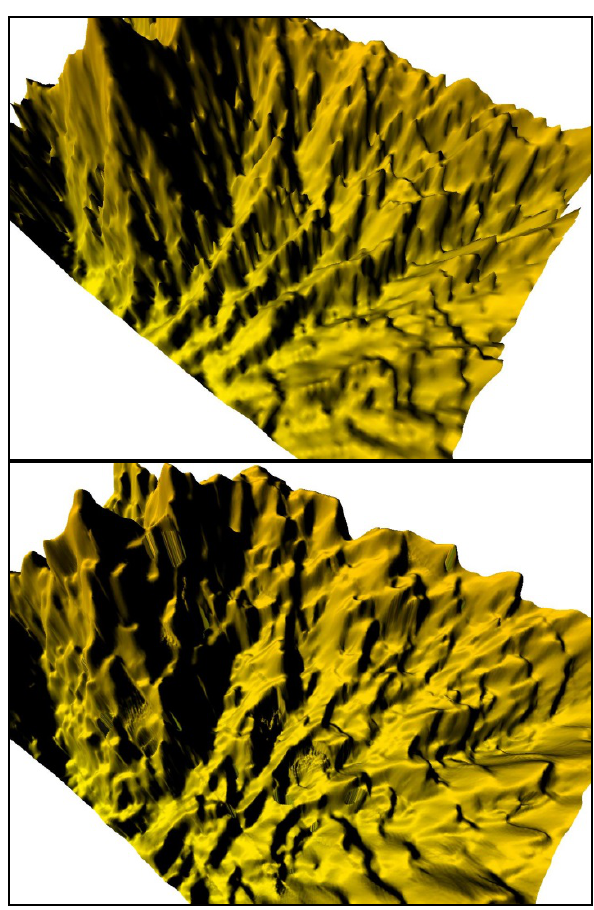
Figure 7. Keramat Hill, Lembang, Bandung: IDEM/12 m GSD (upper) and Improved DEM/6 m GSD